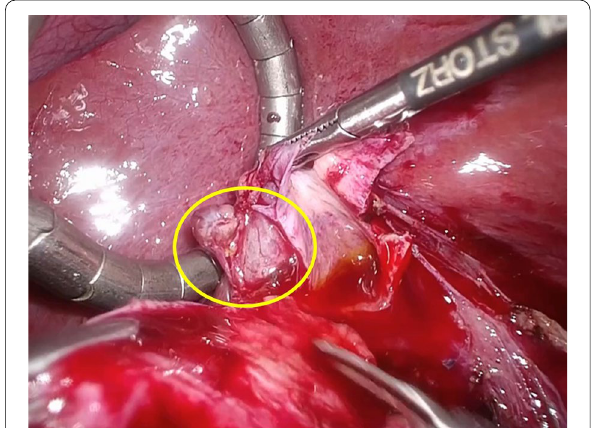
Fig. 3 Intraoperative findings. A cystic structure on the ventral side of the common hepatic duct, slightly to the right (circle), is diagnosed as an ectopic gallbladder during dissection of the common hepatic duct. The distance between the cystic duct and bifurcation is estimated to be 1.5 cm. The ectopic gallbladder is